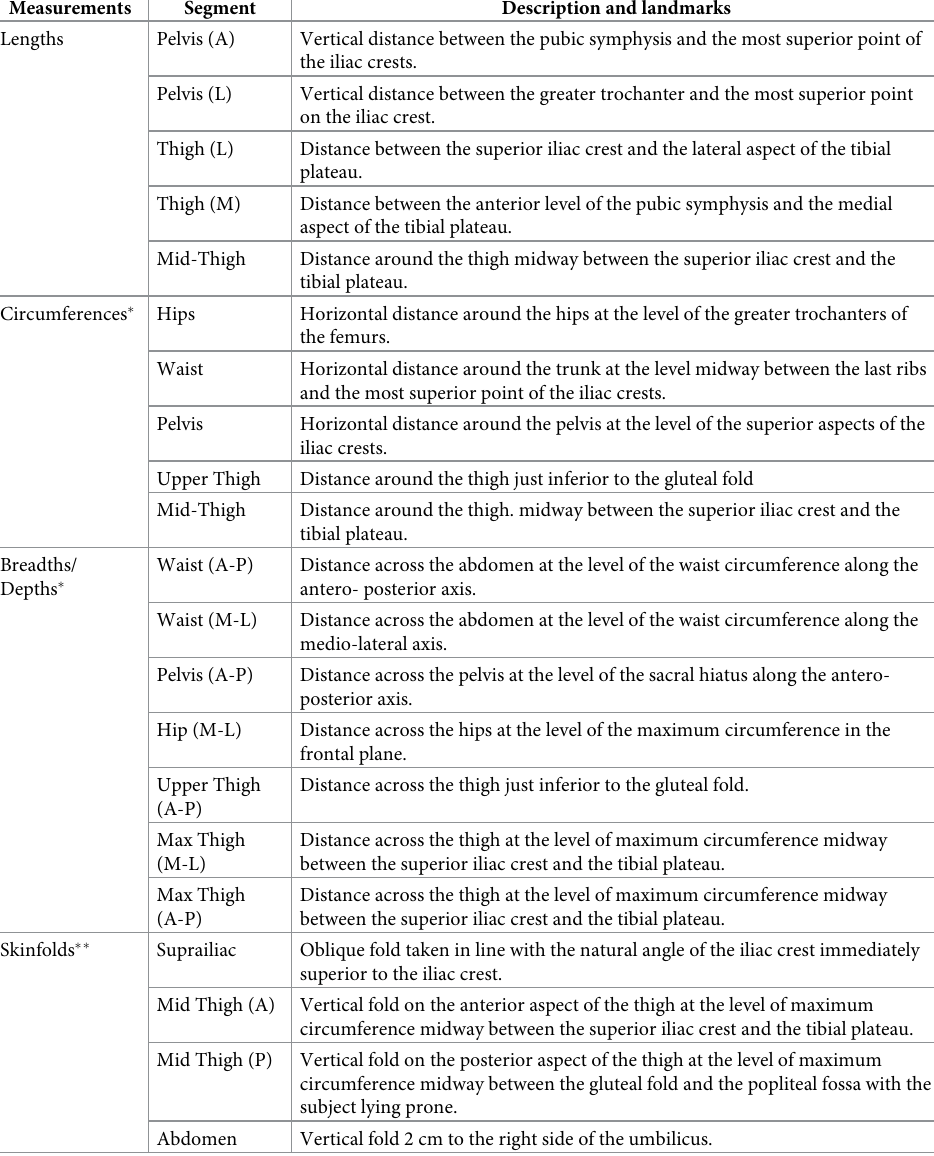
Table 3. Description of anthropometric measurements taken and recorded to the nearest millimetre from the trunk, pelvis, and thigh